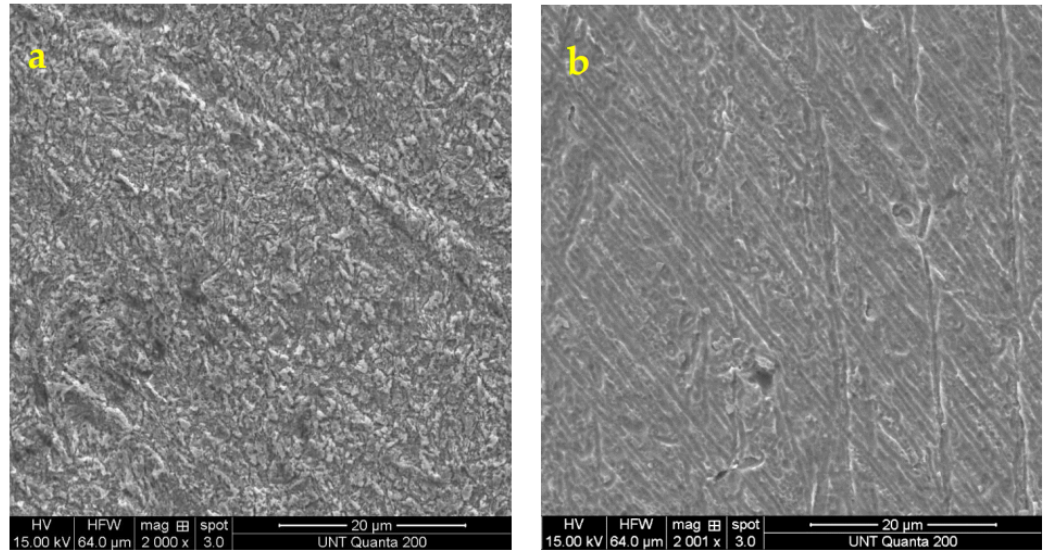
Figure 4. SEM images of brass after immersion in 0.5 M H 2 SO 4 solution ( a ) without any inhibitor for 24 h, 2000 × magnification and ( b ) with 0.25 mM of inhibitor for 24 h, 2000 × magnification.